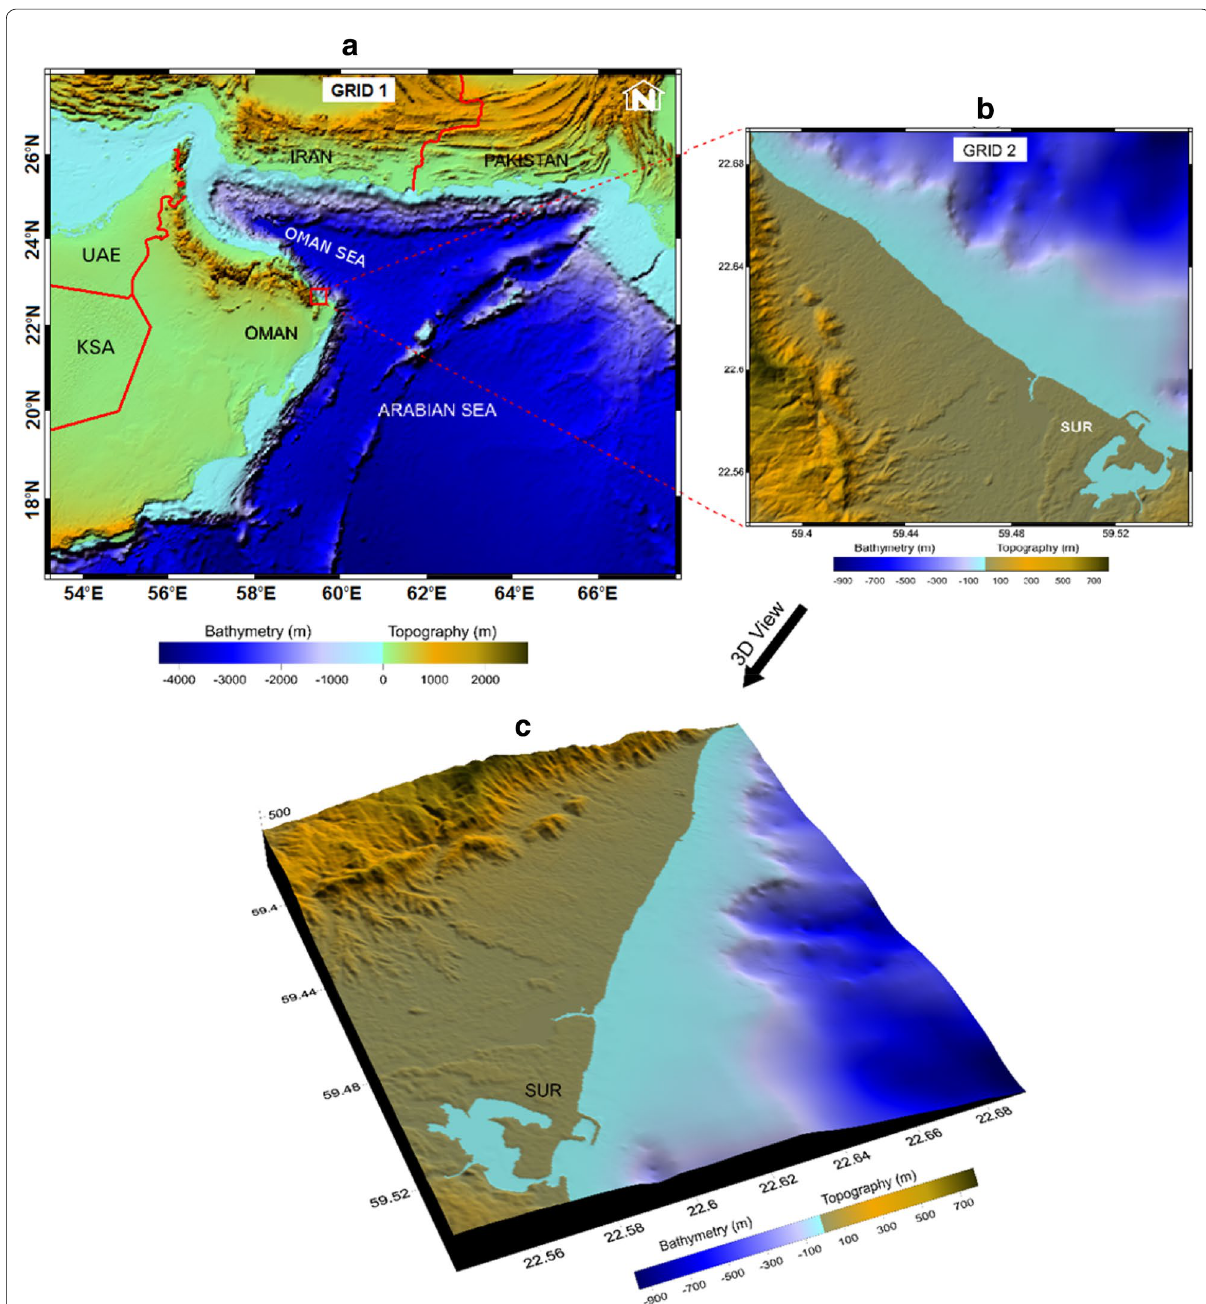
Fig. 3 Digital elevation models: a regional bathymetric/topographic model with 1200‑m horizontal resolution, b high‑resolution (100 m) DEM of the Sur coast and c 3D view of the high‑resolution